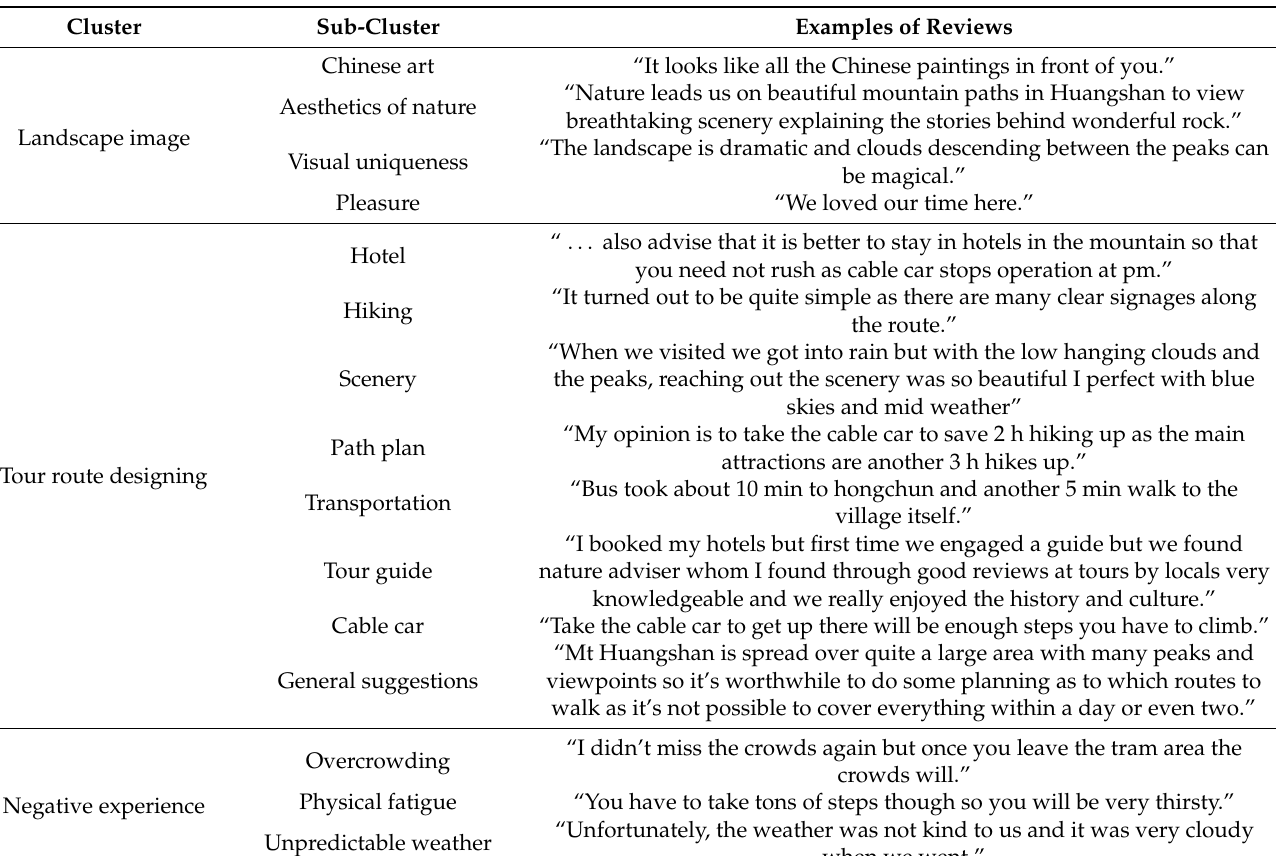
Table 1. Clusters of tourist needs in Mt.